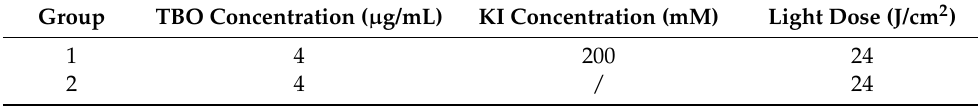
Table 3. Parameters for varying light dose on TBO-mediated aPDT plus